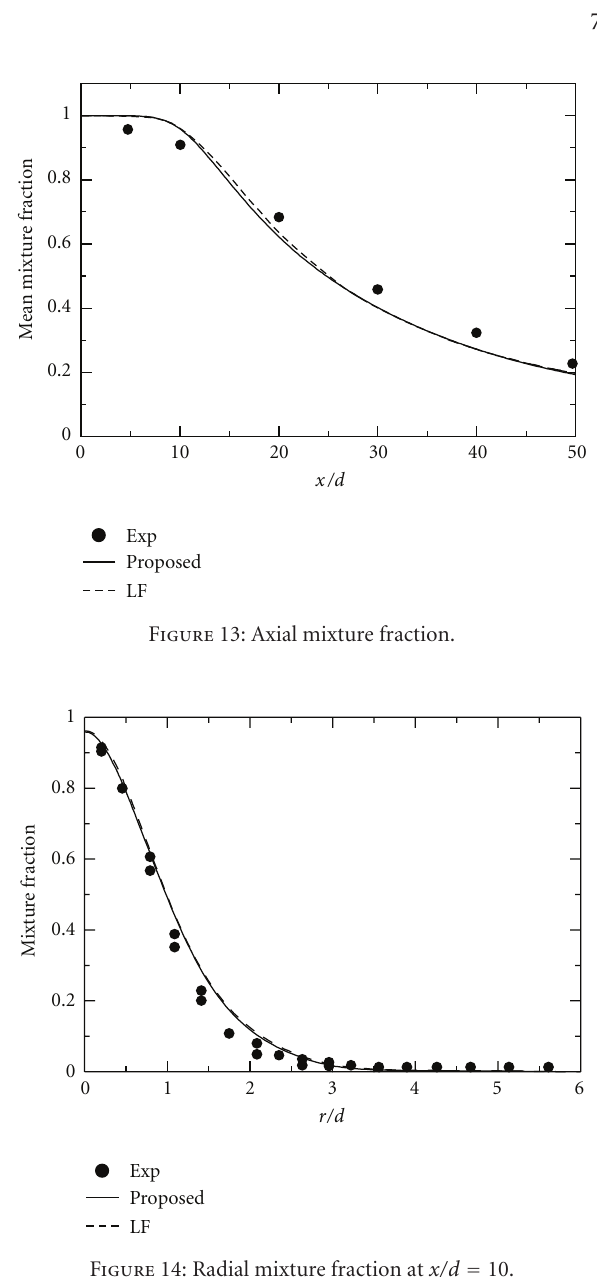
Figure 14: Radial mixture fraction at x/d =